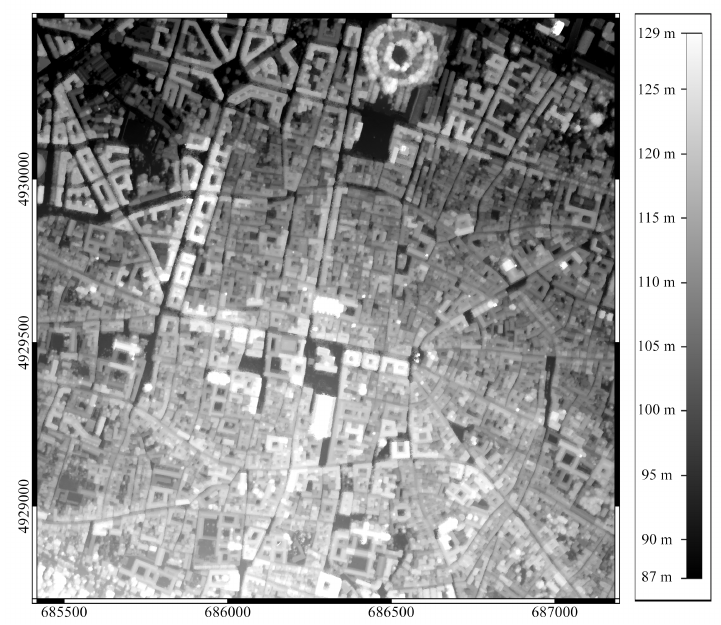
Figure 3. Grey-level visualization of the Average DEM of the city